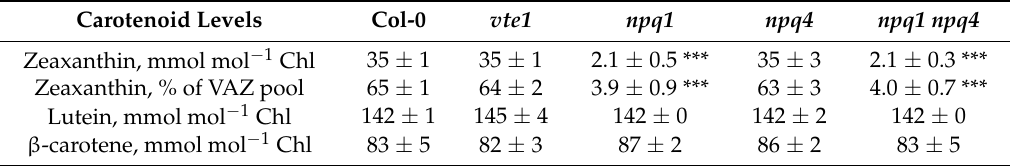
Mean values ± standard deviations ( n = 3). Significant differences (Student’s t -test) between mutants and wild-type Col-0 are indicated by asterisks; *** = p < 0.001. Chl = chlorophyll a + b , VAZ = Violaxanthin + Antheraxanthin + Zeaxanthin.